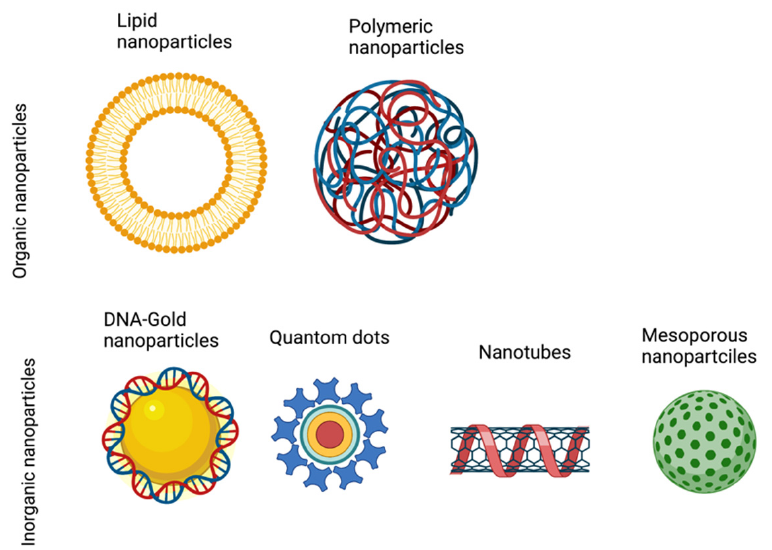
Figure 4. Types of nanoparticles. Schematic diagram showing the different types of nanoparticles, which can be classified into two categories: Organic nanoparticles, including lipid and polymeric particles; and inorganic nanoparticles, including gold nanoparticles, quantom dots, nanotubes, and mesoporous nanoparticles.